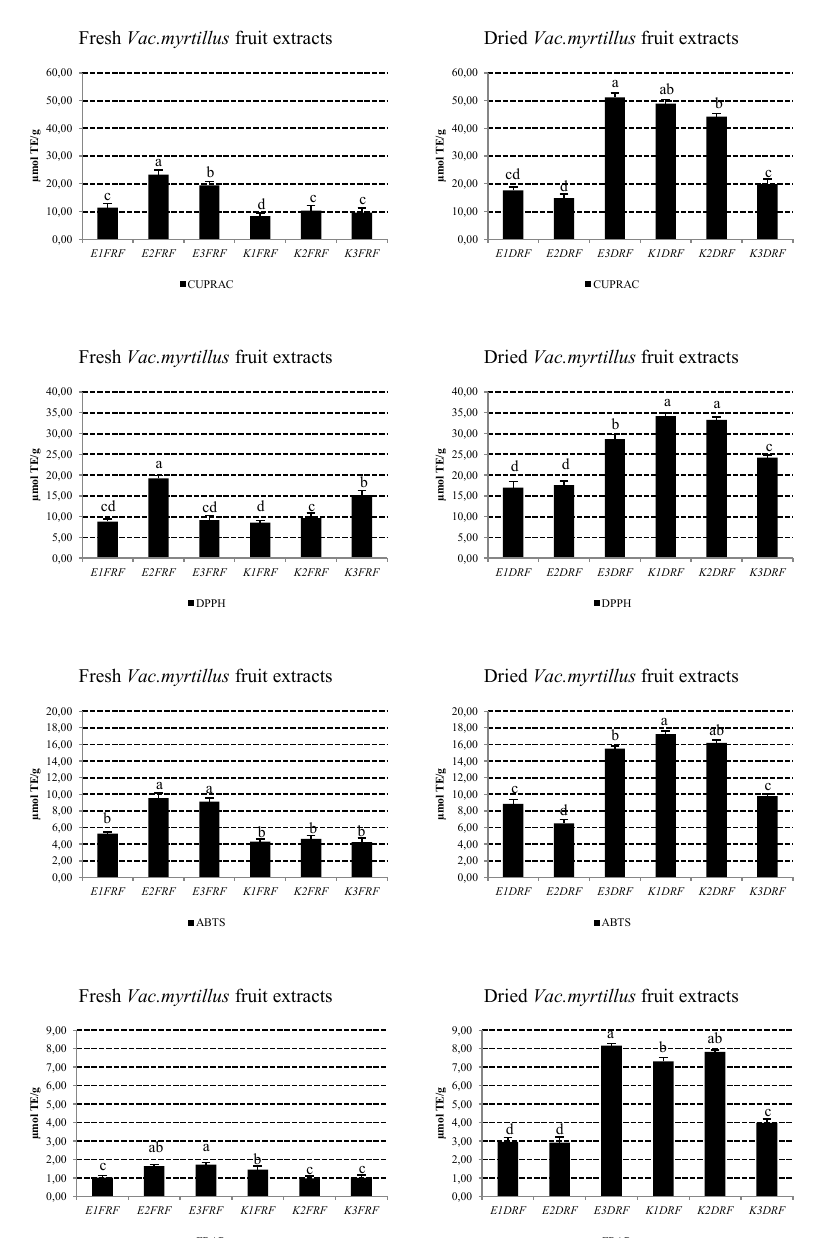
Fig. 3: Antioxidant capacities (μmol TE/g) of fresh and dried Vac. myrtillus fruit extracts (E: Erdek, K. Kapıdağ, FR: Fresh, DR: Dried, F: Fruit, 1-3: Codes of samples collected from different regions, Different letter(s) on bar indicate statistically significant differences, p <0.05)